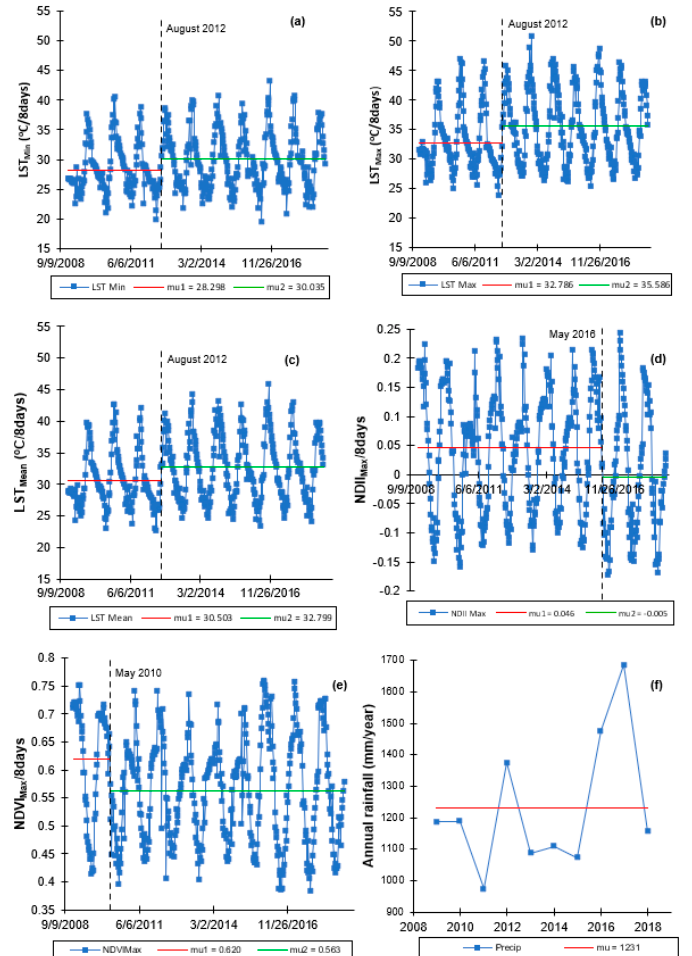
Figure 7. Plots of the Pettit test for the 8-day LST Min ( a ), LST Max ( b ), LST Mean ( c ), NDII Max ( d ), NDVI max ( e ), and mean annual rainfall ( f ) for the period of 2009 to 2018 in the Miombo Woodland in the Luangwa Basin. Significant upward change in the LST means seemed to have occurred in August 2012. Significant abrupt changes in NDII Max and NDVI Max seem to have occurred in May at the start of the dry